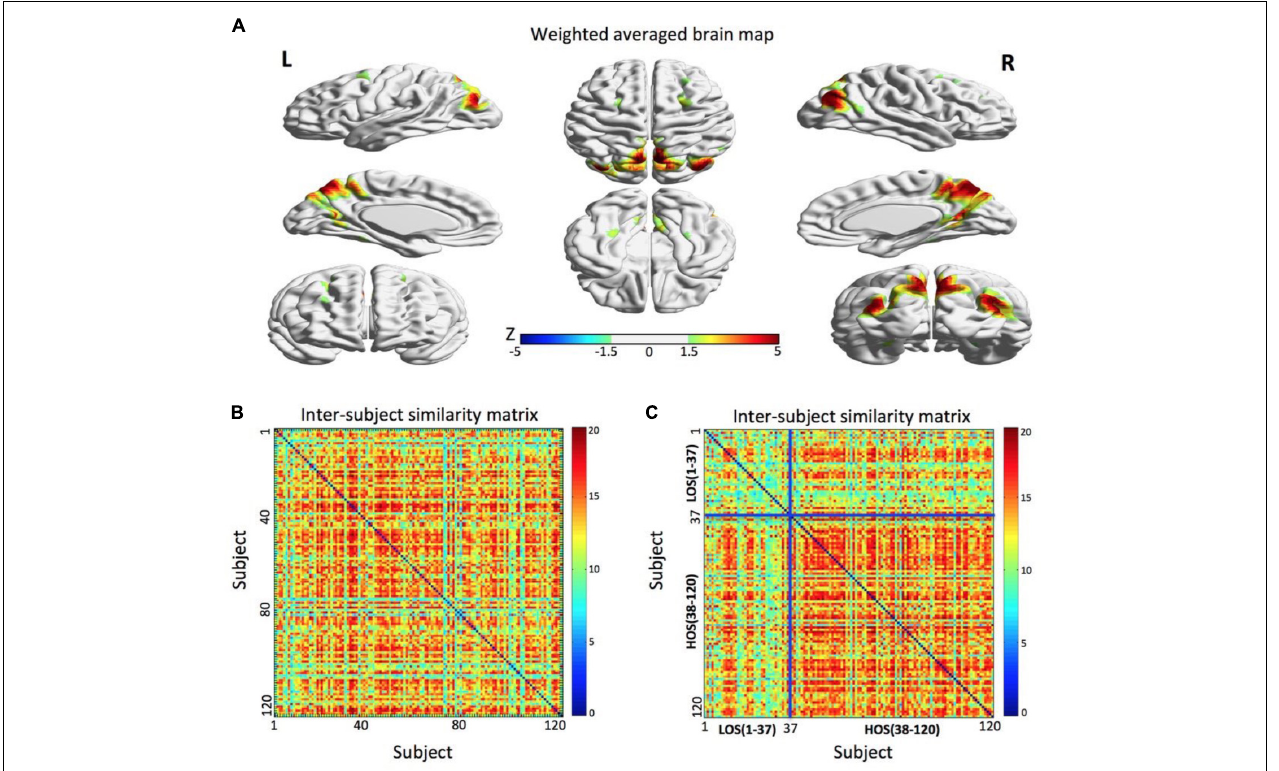
FIGURE 2 | The parietal memory network is associated with openness groups. (A) The parietal memory network rendered onto cortical surface of the brain. The network consists of three brain regions located in the precuneus, left inferior parietal lobule, and right inferior parietal lobule. The maps were thresholded at | Z | > 1.5 for better visualization on the surfaces. (B) The similarity matrix of the parietal memory network across 120 subjects has no regular distribution. Both horizontal and vertical axes represent subjects. (C) Combined with the openness scores, the similarity matrix change into a regular distribution. Compared to the LOS subjects, the HOS subjects have a higher inter-subjects average similarity. For visualization purpose, the subjects are grouped into LOS and HOS groups, and the blue solid lines mark the boundary between the two groups. All surface maps are rendered in BrainNet Viewer (Xia et al.,